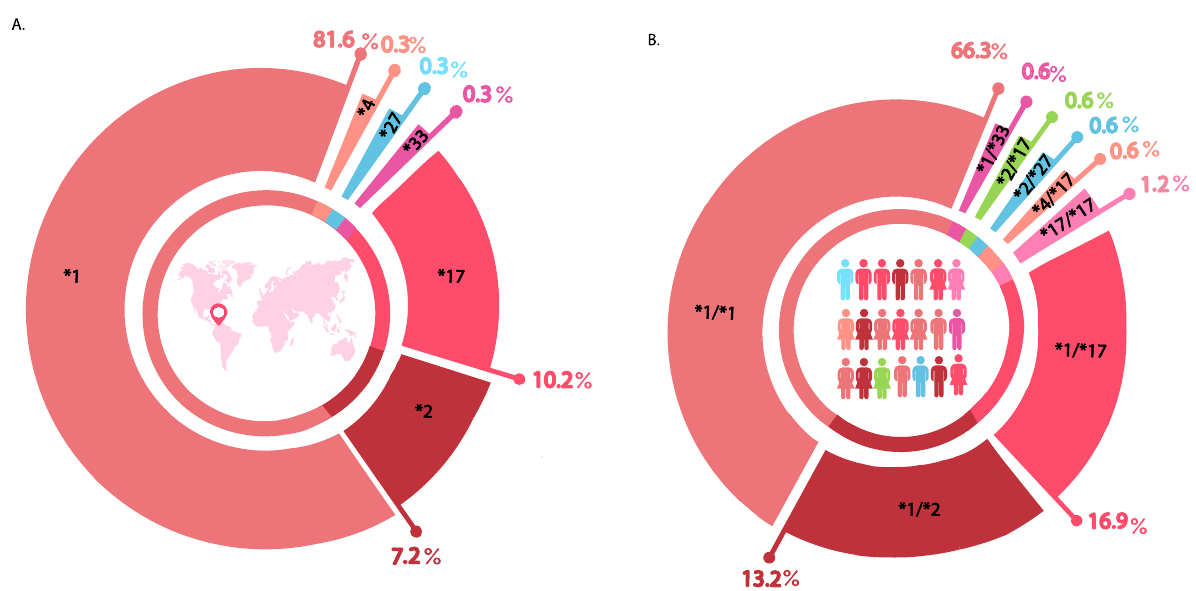
Figure 1. Allele and genotype frequencies. Data for allele and genotype frequencies of CYP2C19 are illustrated. ( A ) Allele frequency and ( B ) genotype frequency.